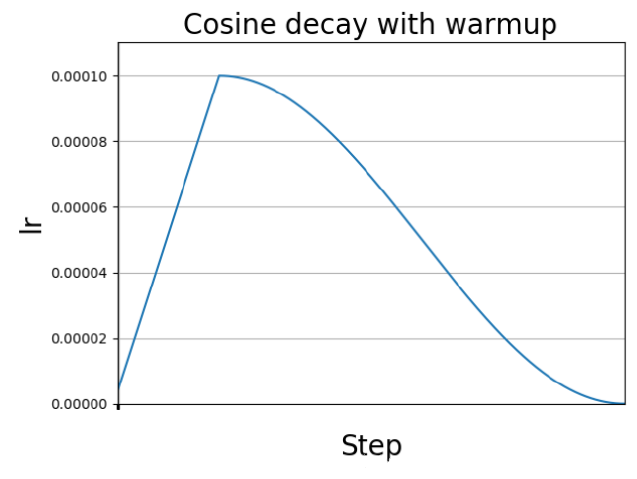
Figure 14. Learning rate cosine annealing decay.